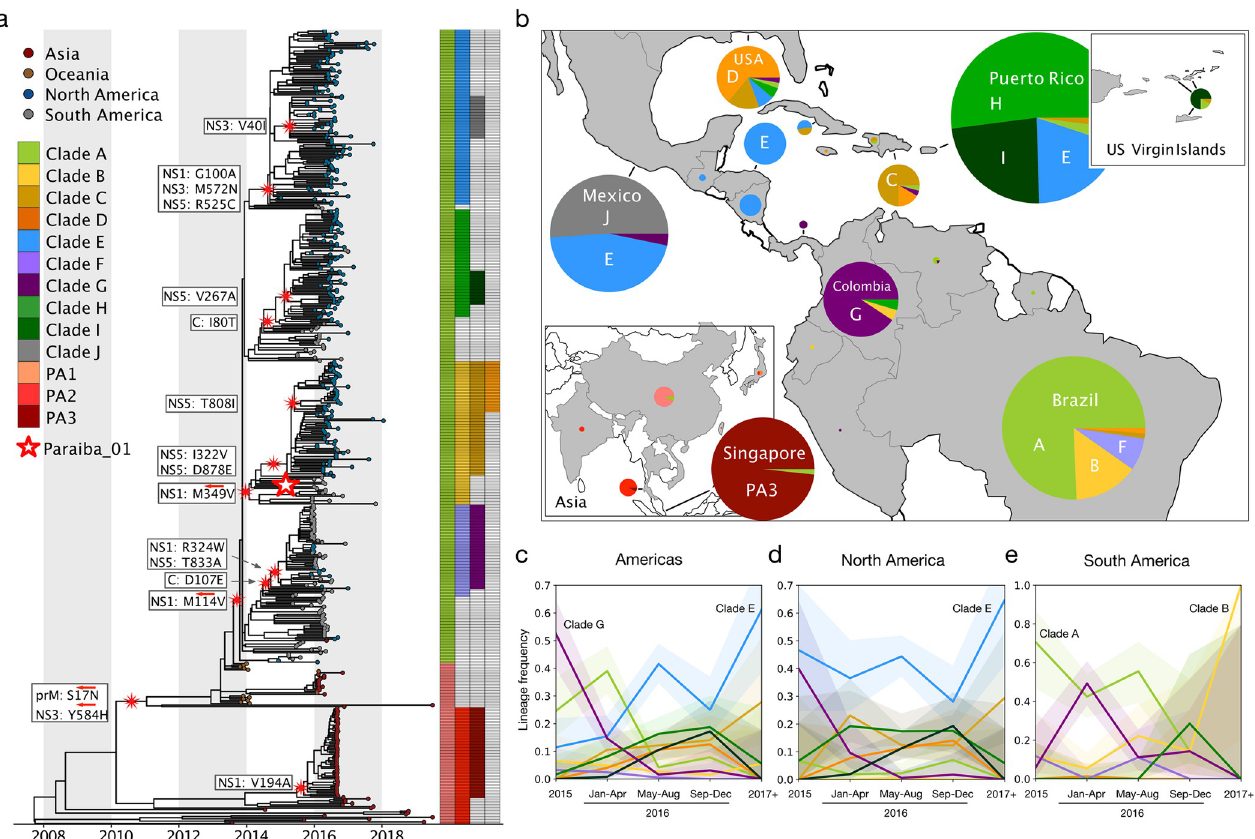
Fig 1. 13 major Zika virus lineages defined by nonsynonymous mutations. (a) Zika phylogeny partitioned into 13 lineages defined by nonsynonymous mutations. Large red and white star: location of the initial infectious clone into which specific mutations were introduced. White boxes: nonsynonymous mutations introduced into the initial infectious clone to model each lineage. Red arrows: lineage-defining nonsynonymous mutations that were reverted to their ancestral states. (b) Proportions of clades circulating in countries across the Americas and Asia. Pie sizes represent the number of sequences. (Map made with the coastlines basemap from Natural Earth.) Temporal frequencies of sequenced ZIKV isolates across the Americas (c) , North America (including the Caribbean and Central America) (d) , South America (e) with 95% confidence intervals. Timepoint 2015- represents isolates collected during or before 2015. Timepoint 2017+ represents isolates collected during or after